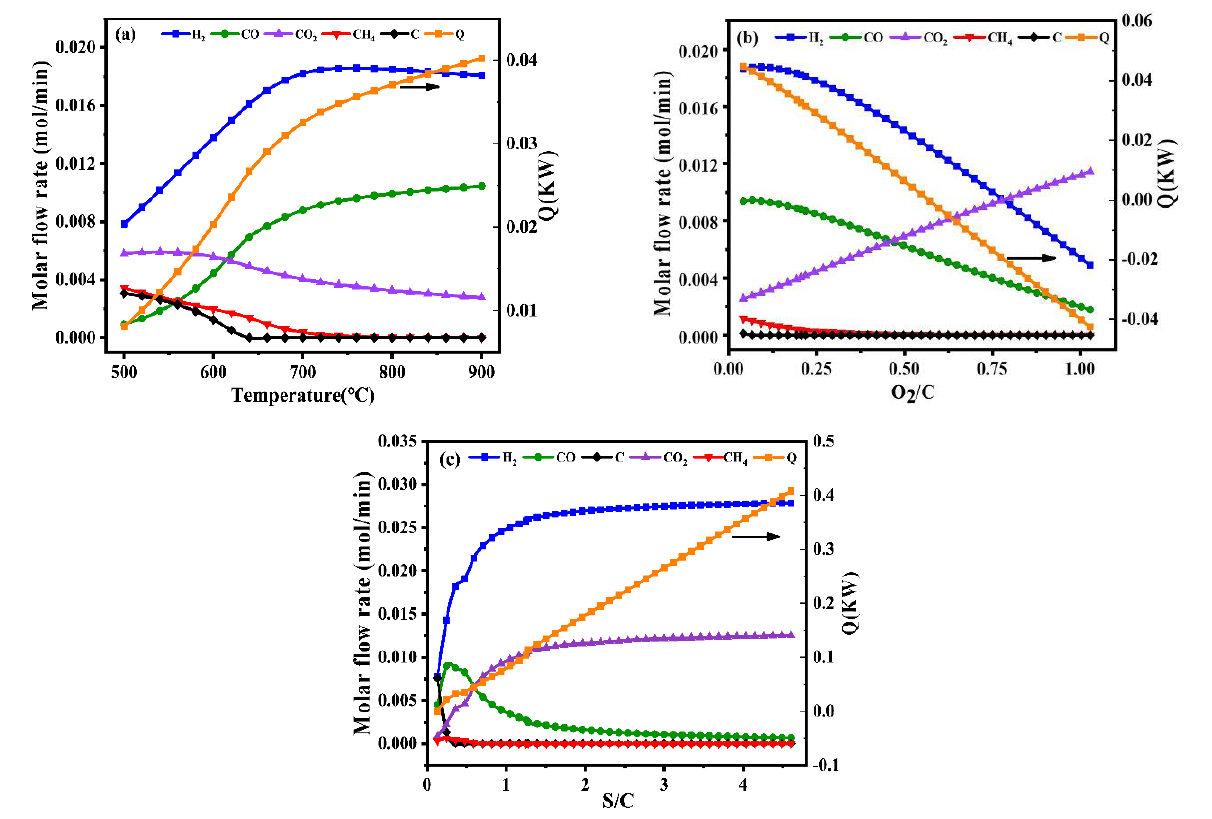
Figure 1. Product gas composition of different temperatures at the S/C = 1.31 and O 2 /C = 0.225 ( a ), product gas composition of different oxygen-to-carbon at the temperature = 700 °C and S/C = 1.31 ( b ), product gas composition of different steam-to-carbon at the temperature = 700 °C and O 2 /C = 0.225 ( c ) by simulation with Gibbs free energy minimization.